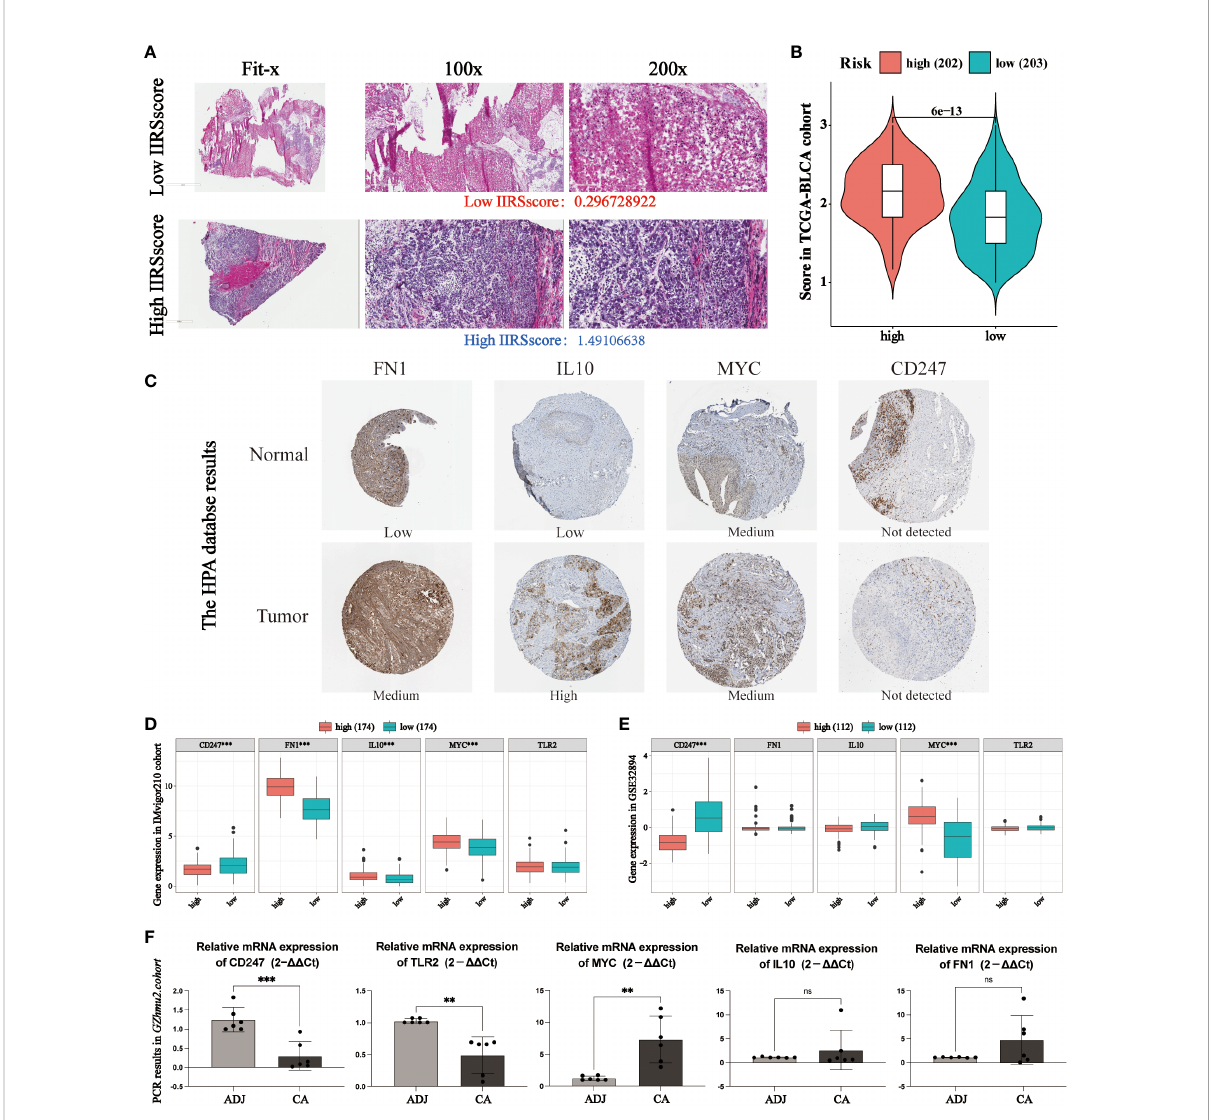
FIGURE 6 Evaluation of the expression of identi fi ed IIRS genes. (A) Representative photomicrographs of H&E staining of bladder sections between high or low IIRS-score groups. (B) Student ’ s T-test of histopathological scores between high or low IIRS-score groups. (C) The representative images of the immunohistochemical labeling of the identi fi ed genes of IIRGS on bladder tissues. Data were obtained from the human protein atlas (https://www.proteinatlas.org/). (D, E) Differences in the levels of the 5 identi fi ed genes of IIR signature in GEO cohorts. (F) Differences in the levels of the 5 identi fi ed genes of IIR signature in bladder cancer (CA) tissues and adjacent (ADJ) normal tissues. ***P < 0.001; **P < 0.01; ns refer to not statistically signi fi